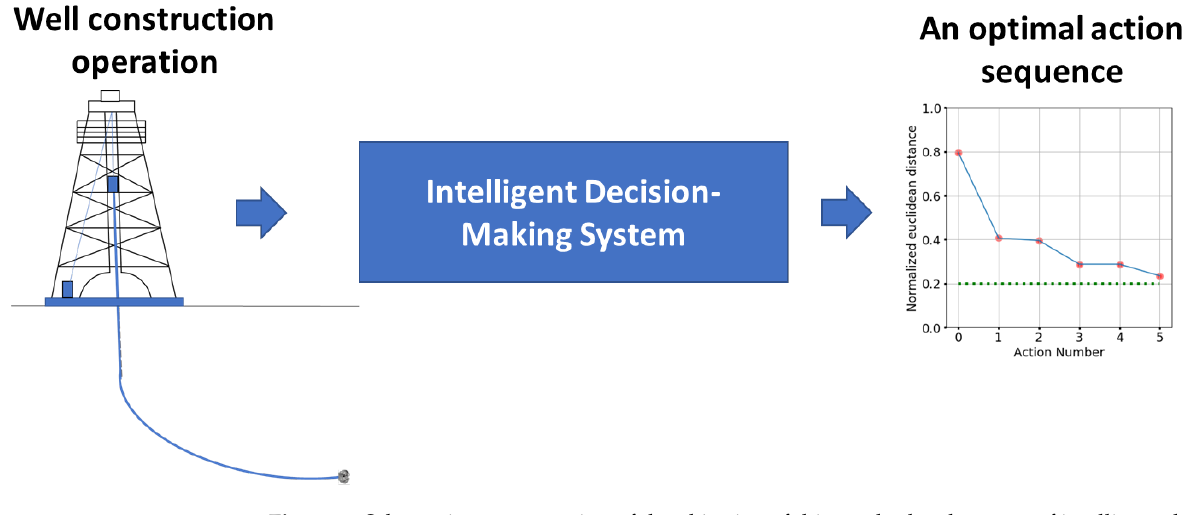
Figure 1. Schematic representation of the objective of this work: development of intelligent decision- making systems for well construction operations. The right figure shows progression of the normalized Euclidean distance of the system states (blue line) to an acceptable goal state (shown by the green dotted line, here taken to be a state at a normalized Euclidean distance of 0.2)